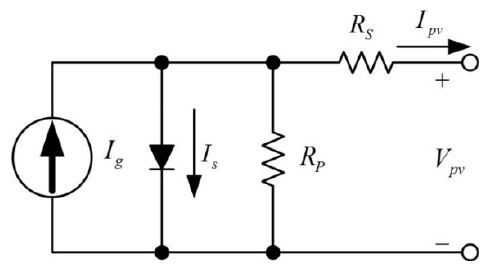
Figure 2. Equivalent circuit of the PV cell.